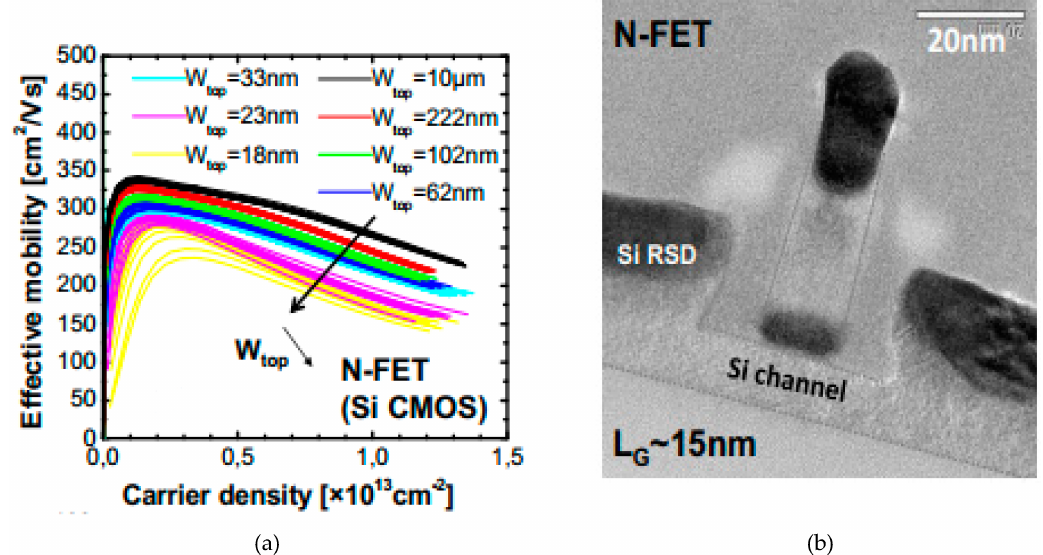
Figure 16. ( a ) Electron effective mobility in NFET and ( b ) TEM images Ω -Gate CMOS NW transistors for N-FET [108].